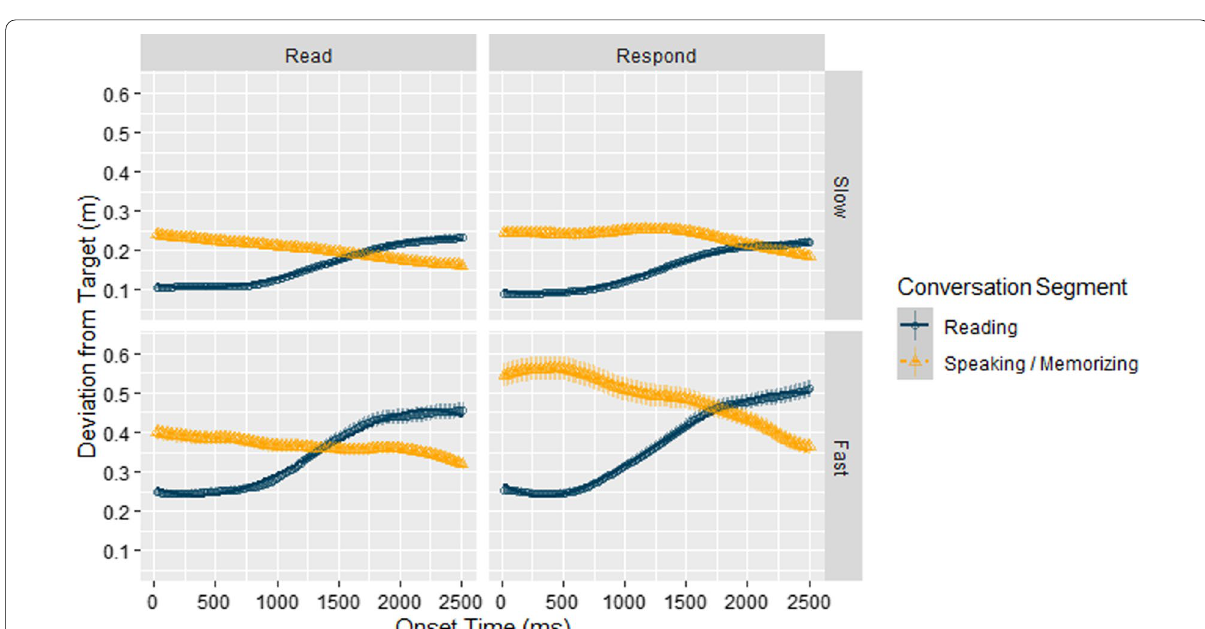
Fig. 8 Deviation from target during first 2500 ms of segment onset for Slow and Fast speeds during Read and Respond conversation conditions in E2. Error bars show the SEM. Note that for reasons of graphical clarity, the scales of this figure are different than those used in Fig. 3